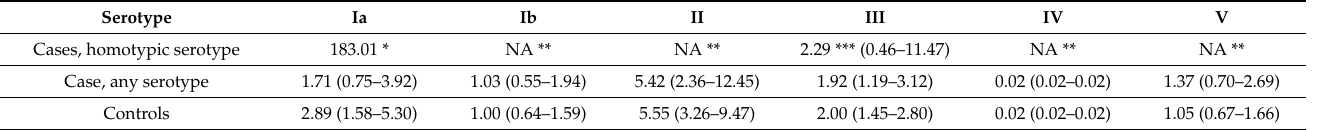
Table 2. Geometric mean antibody concentrations in the cases and controls (µg/mL).